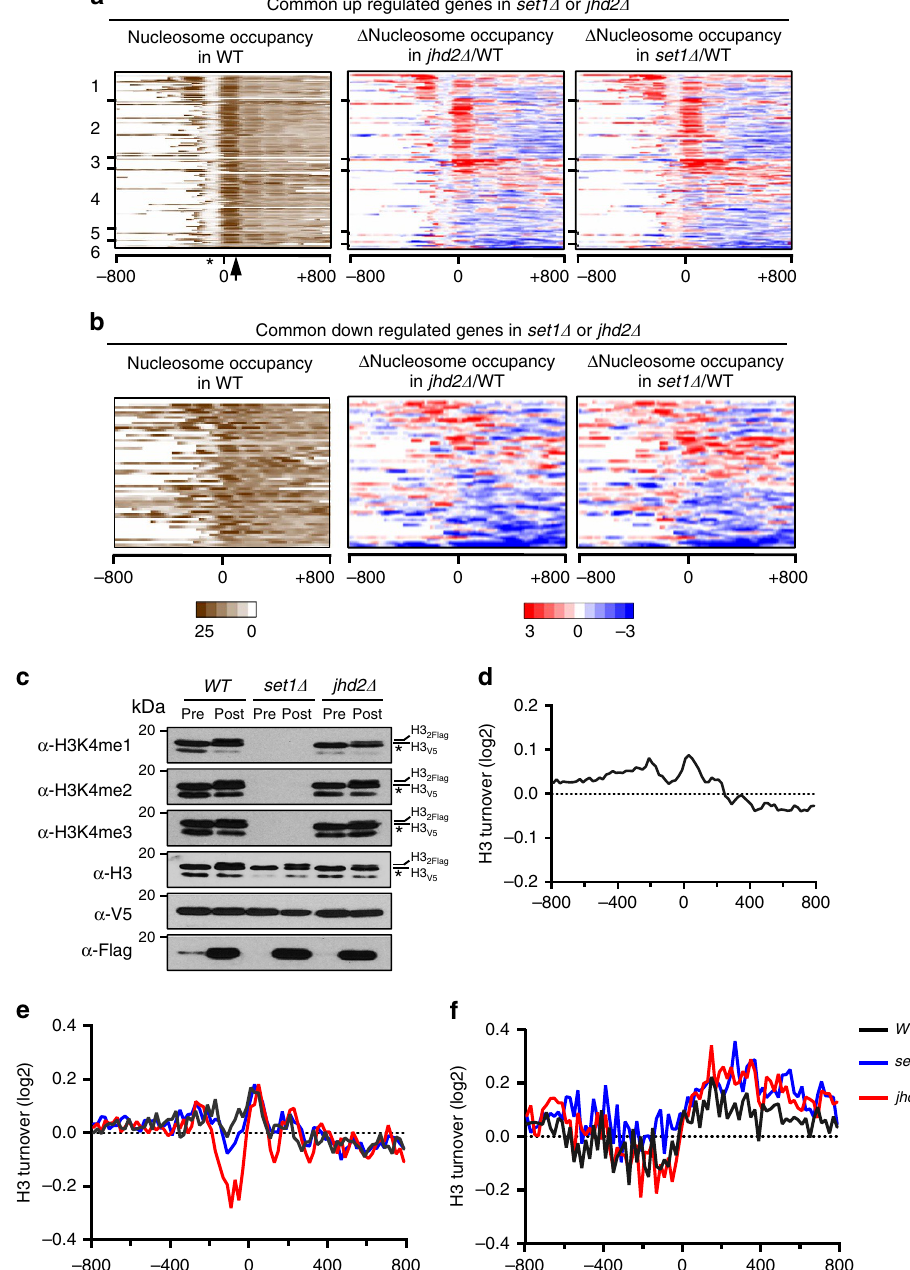
Figure 4 | Set1 and Jhd2 co-regulate nucleosomal occupancy and histone turnover at their shared target genes. ( a , b ) Heat maps for nucleosome occupancy ratios ( D nucleosome occupancy) between jhd2 D and WT or between set1 D and WT at genes either co-repressed ( a ) or co-activated ( b ) by Set1 and Jhd2. Red, gain in nucleosome occupancy; blue, loss in nucleosome occupancy. Genes in rows are organized into six groups using k -means clustering. Columns represent 50bp windows over ± 800bp regions relative to the TSS (0). Windows overlapping neighbouring genes were excluded. Total reads for mononucleosomal DNA in WT show the native state of nucleosome occupancy (leftmost panel). Asterisk, NDR; black arrow, the well-positioned þ 1 nucleosome. ( c ) Western blots showing RITE. WT , set1 D and jhd2 D strains expressing histone H3 tagged with V5- LoxP -HygMX- LoxP -2Flag cassette were grown overnight in YPD medium and then grown to saturation followed by addition of b -estradiol to induce tag switch. Saturated cultures were re-inoculated into fresh medium to release cells into the cell cycle in the presence of b -estradiol. Cells were arrested in G1 using a -factor. Cells before addition of b -estradiol (pre) and b -estradiol-treated G1 cells (post) were collected for whole-cell lysate preparation and detection of old (V5) and new (Flag) histone H3. The levels of H3K4me1, H3K4me2, H3K4me3 and total histone H3 in the indicated strains are shown. 2Flag , two copies of Flag tag; asterisk, truncated H3. See Supplementary Fig. 22 for full-length image of blots. ( d ) The average mean profile for histone H3 turnover across 800bp region upstream ( (cid:2) ) or downstream ( þ ) of the TSSs (0) at all yeast genes. ( e , f ) Mean profiles for histone H3 turnover across regions (as described for d ) at genes co-repressed ( e ) or co-activated ( f ) by Set1 and Jhd2 in WT, set1 D and jhd2 D